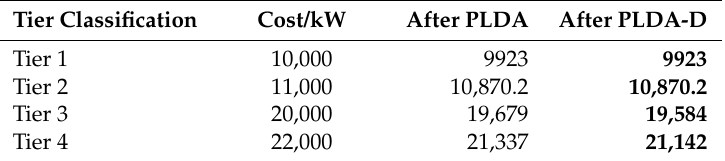
Table 4. Relation between cost/kW before/after PLDA and